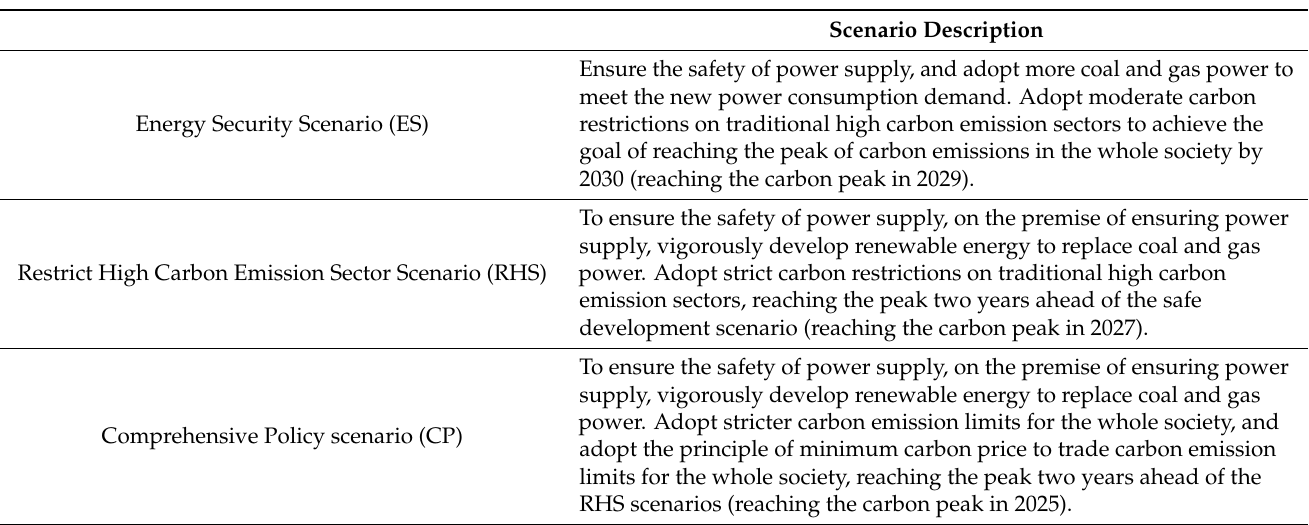
Table 4. Policy scenario description and parameter